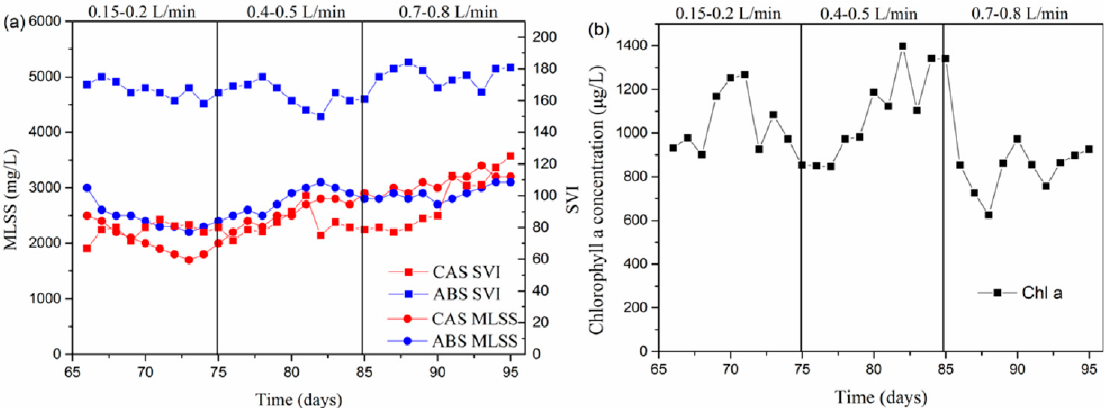
Figure 8. Biochemical indicators of the CAS system and ABS system under different aeration conditions: 0.15 – 0.2 L/min, 0.4 – 0.5 L/min, 0.7 – 0.8 L/min ( a ) and chlorophyll a concentration of ABS system under different aeration conditions: 0.15 – 0.2 L/min, 0.4 – 0.5 L/min, 0.7 – 0.8 L/min ( b )